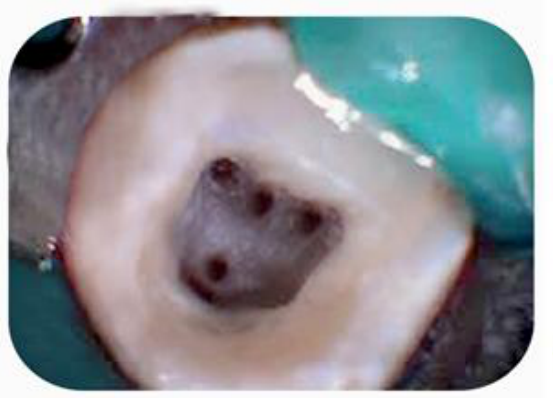
Figure 3: View of pulp chamber under operating